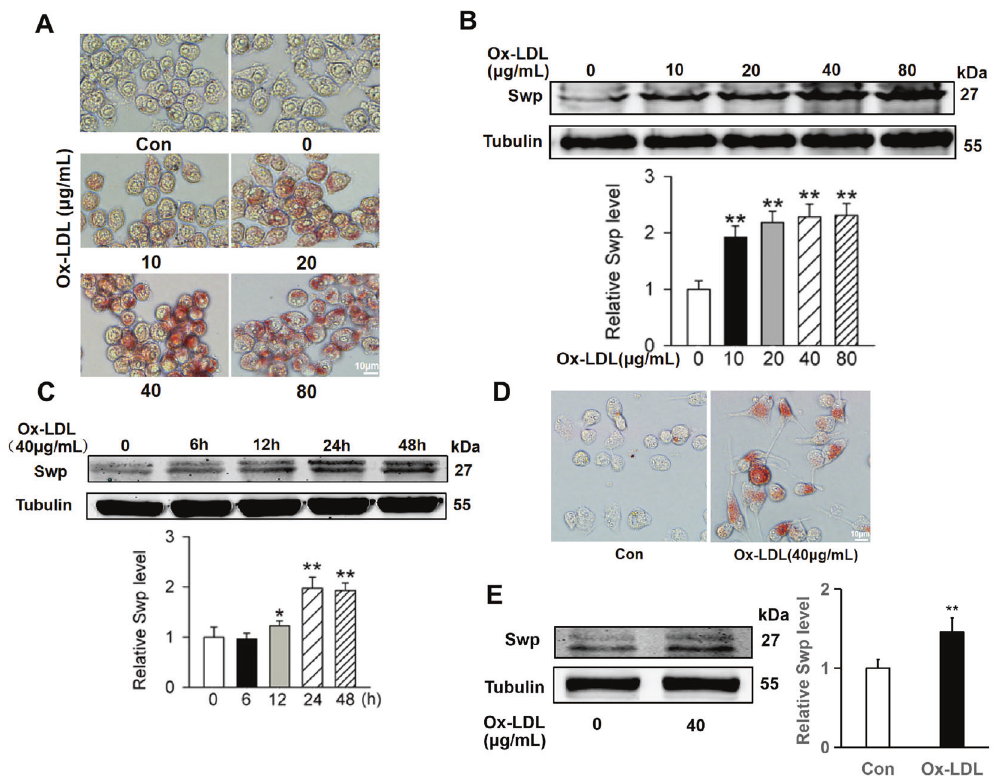
Fig. 2 Swiprosin-1 expression increased in macrophage induced by ox-LDL. A Representative images of RAW264.7 cells stained with Oil Red O after induced by ox-LDL for 24 h. n = 3/group. Scale bars are 10 μ m. B Representative Western blot for swiprosin-1 expression in RAW264.7 cells induced by different doses of ox-LDL for 24 h (upper) and densitometric analysis of swiprosin-1 expression (down). Tubulin served as the loading control. Data are presented as the mean ± SE; ** P < 0.01, n = 3/group. C Representative Western blot for swiprosin-1 expression in RAW264.7 cells induced by ox-LDL at different time intervals (upper) and densitometric analysis (down). Tubulin served as the loading control. Data are presented as the mean ± SE; ** P < 0.01, n = 3 per group. D Representative images of primary peritoneal macrophages from C57BL/6 mouse stained with Oil Red O after induced by ox-LDL (40 μ g/mL) for 24 h. Scale bars are 10 μ m. E Representative Western blot for swiprosin-1 expression in primary peritoneal macrophages from C57BL/6 mouse induced by ox-LDL for 24 h (left) and densitometric analysis (right). Tubulin served as the loading control. Data are presented as the mean ± SE; ** P < 0.01, n = 3 per group. Con control, ox-LDL oxidized low- density lipoprotein, Swp